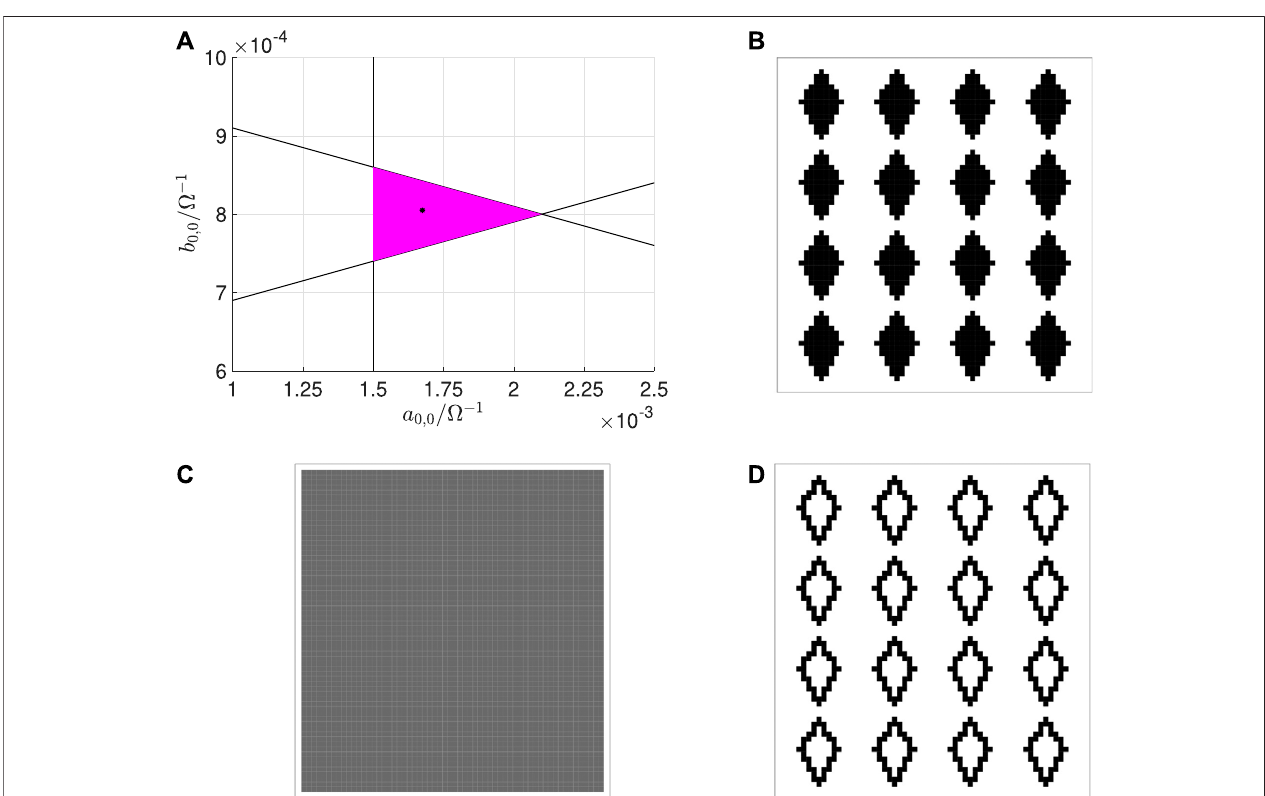
FIGURE 16 | (A) Geometry-based approach to the solution of the system of three non-redundant inequalities, resulting from the application of the systematic M-CNN design methodology from section 3.3 for the accomplishment of the binary image edge extraction task. The magenta region contains the set of admissible solutions of the constraint triplet, which consist of inequality Eq. 55 , and of the couple of conditions descending from the constraint pair Eq. 57 under the fi rst inequality sign option in the worst-case scenario n B (cid:1) 0 from rule 1, and in the only possible scenario n B (cid:1) 8 from rule 2, respectively. Recalling the invariable cell circuit parameter setting, reported in Table 3 , and setting z , b , and G x to − 1 · 10 − 4 , − 1 · 10 − 4 Ω − 1 , and 1 · 10 − 3 Ω − 1 , respectively, these three inequalities are in turn found to assume the analytical expressions a 0 , 0 > 1 . 5 · 10 − 3 Ω − 1 , b 0 , 0 > 1 · 10 − 1 · a 0 , 0 + 5 . 9 · 10 − 4 Ω − 1 , and b 0 , 0 < − 1 · 10 − 1 · a 0 , 0 + 10 . 1 · 10 − 4 Ω − 1 . For the particular solution, highlighted by means of an asterisk marker, speci fi cally ( a * 0 , 0 , b * 0 , 0 ) (cid:1) ( 1 . 675 · 10 − 3 Ω − 1 , 80 . 5 · 10 − 5 Ω − 1 ) , and residing inside the magenta triangle at some safety distancefromitssides,plots (A – C) of Figure13 showtheSDPsfoliatingfromtheresultingEDGEM-CNNcellDRM 2 intheworst-casescenario n B (cid:1) 0fromrule1,inthe only possible scenario n B (cid:1) 8 from rule 2, and in the worst-case scenario n B (cid:1) 7 from rule 3, respectively. For the sake of completeness, referring to Figure 14 , the speci fi cation of the aforementioned solution for the non-redundant IS de fi nes the course of the graph of the function v x ((b.3)) for rules 1 and 2 (for rule 3), setting, to name but the most important cases, η ( v u well as to 72 . 5 μ A under rule 2 (to − 62 . 5 μ A for n B (cid:1) 7 and to 137 . 5 μ A for n B (cid:1) 6 under rule 3). (B – D) Proof of evidence for the proper functionality of a M × N M-CNN programmed through thegene synthesized in thissection ( M (cid:1) 64, N (cid:1) 60). Plot (D) depicts thesteady-state output binary image ofthe EDGEM-CNN,once theblack- and-whiteimage,illustratedinplot (B) ,isloadedtoitsinput,azeroisassignedtothevoltagefallingacrosseachcapacitoratthebeginningofthesimulation,asvisualized throughthegrayimage inplot (C) ,theinitialconditionontheresistanceofeachmemristorissetto5 k Ω ,andanegative 1 Vvalueisattributed totheinputvoltageofany virtual cell (Chua and Roska,